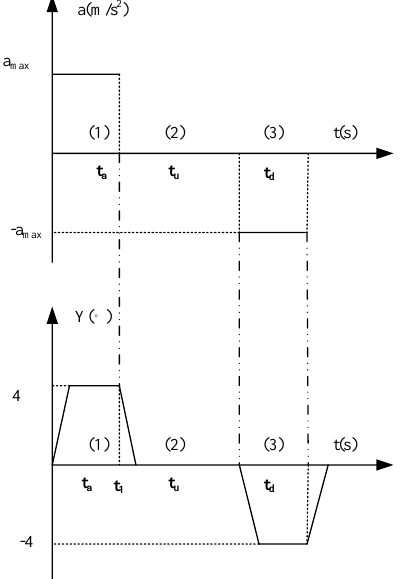
Figure 10. Equivalent conversion of trolley motion curve.